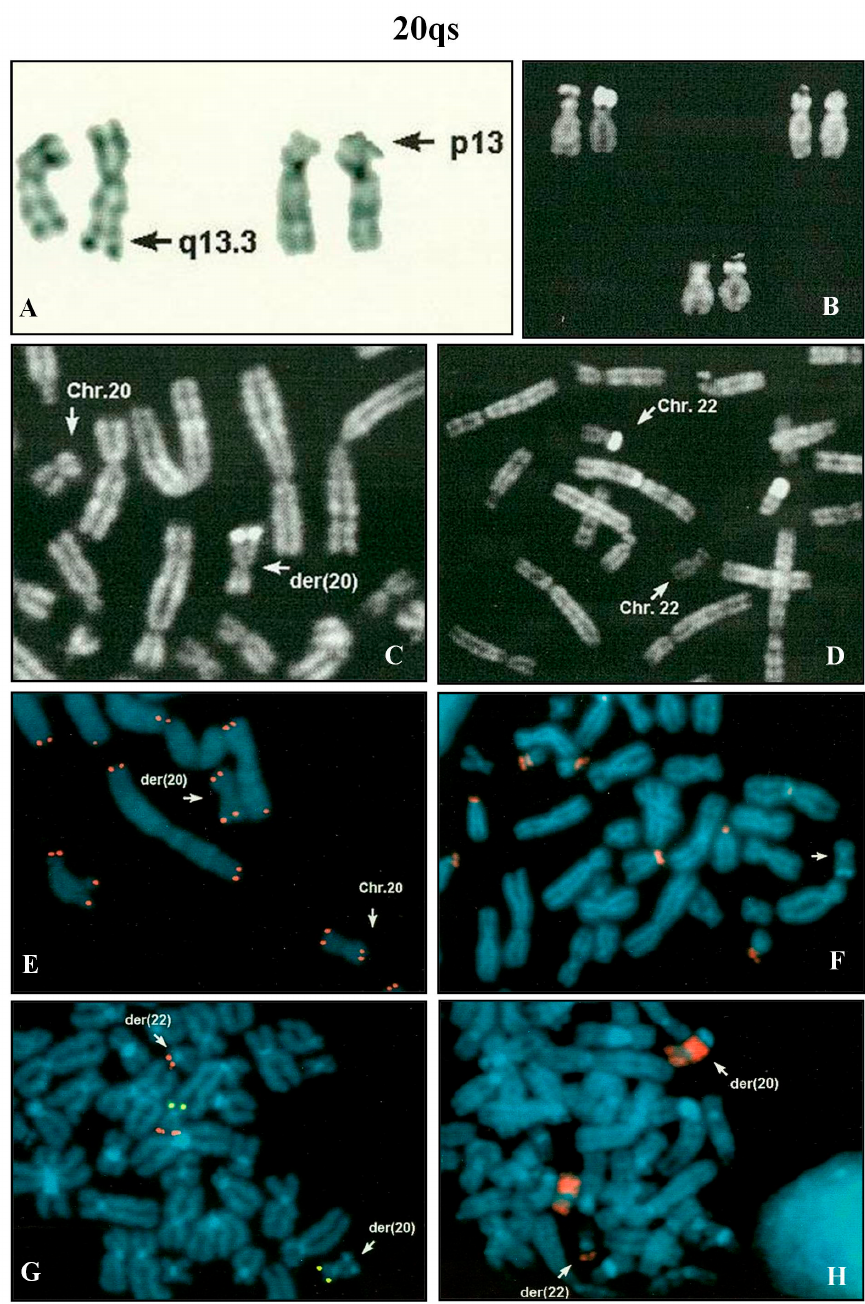
Figure 4. 20qs: ( A ) reciprocal translocation involving a chromosomes 20 and a chromosome 22 (GTG banding); ( B ) chromosomes 22 of whole family: father (left), mother (right) and fetus (below) showing the brilliant 22 satellites in the father karyotype, absent in fetus because translocated on 20q; ( C ) partial fetal QFQ banded metaphase with both chromosomes 20 arrowed; ( D ) partial paternal QFQ banded metaphase with both 22 arrowed; ( E ) FISH on fetal metaphase with pan-telomeric probe marked all chromosomes, included the der(20); ( F ) FISH with β -satellite probe evidenced both chromosome 22 with hybridization signals, while the der(20) was negative (arrow); ( G ) partial fetal metaphase after FISH with specific subtelomeric probes of chromosome 20 (green p-arm and red q-arm). Subtelomeric 20q red signal was on derivative chromosome 22p arm; ( H ) partial fetal metaphase after FISH with whole chromosome 20 painting: wcp20 painted all der(20), but not the satellited region, small signals of hybridization were also evident on 22 p arm. All images were captured at 100 × magnification (see materials and methods for details).